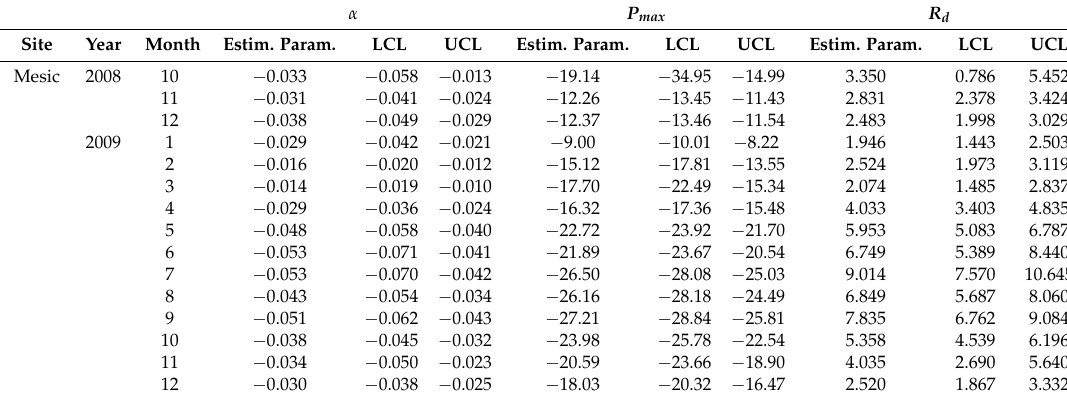
Distribution of parameters from daytime net ecosystem exchange (NEE day ) bootstrap